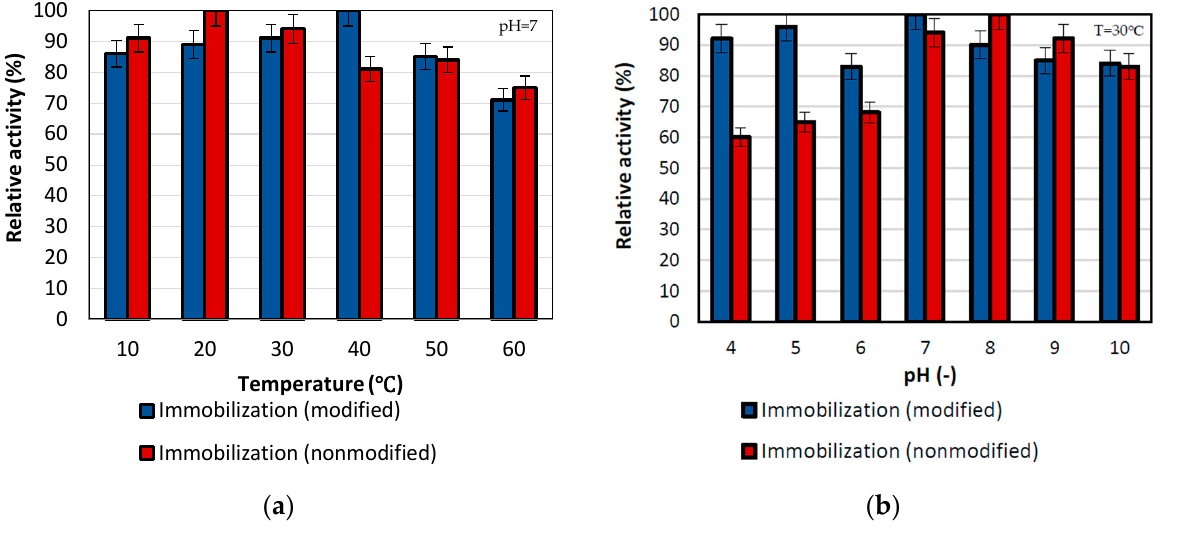
Figure 3. Effect of ( a ) temperature and ( b ) pH on immobilized lipase activity. All experiments were performed in duplicate and the results presented in each of the graphs are shown as a mean value, for which standard deviation (error value) does not exceed 5%. During investigation in varying temperature, reactions were performed in 100 mM phosphate buffer at pH 7, while reactions conducted in different pH were performed in the temperature of 30 °C.